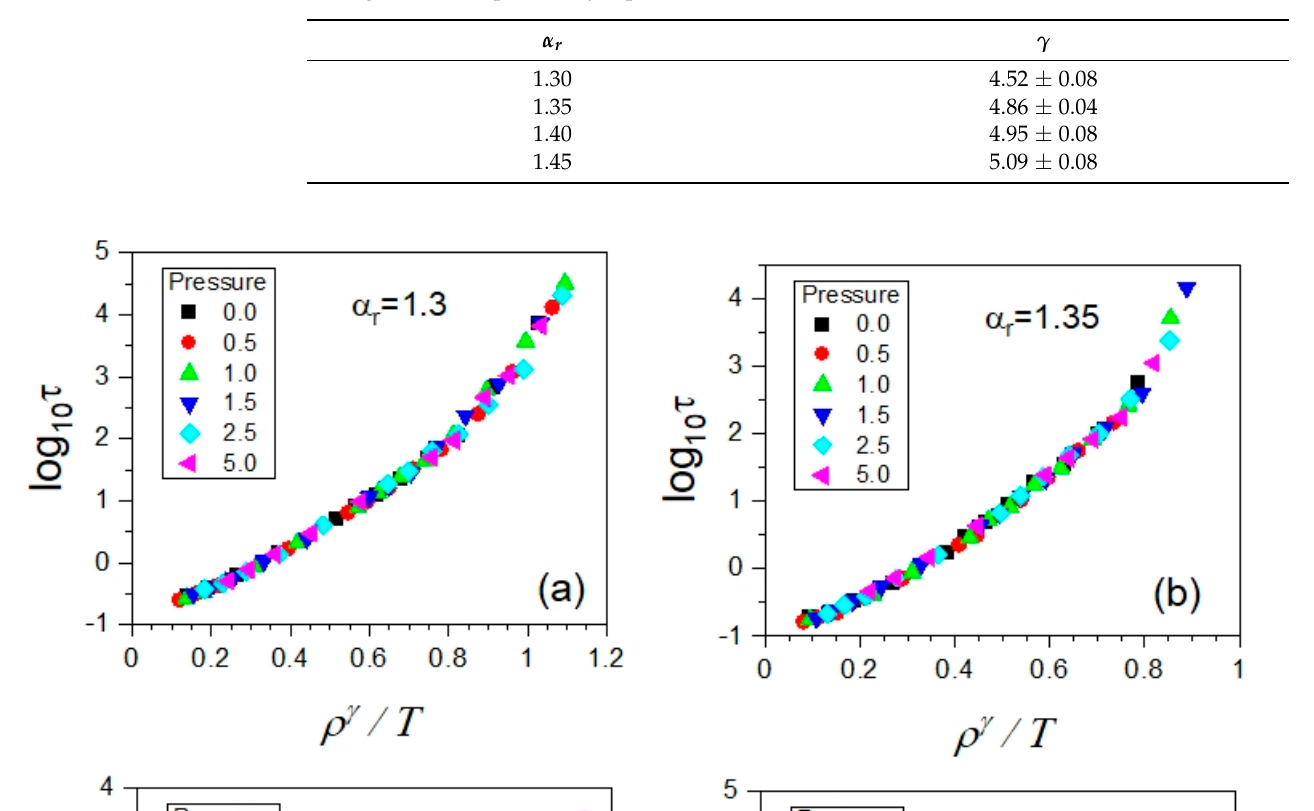
Table 2. The values of the density scaling exponent γ evaluated according to the density scaling criterion for all examined anisotropy aspect ratios α r as the slope coefficient of the linear isochronal correlations presented in Figure 5. The determination errors of the slope coefficient values are estimated as the standard deviation errors found from the linear regression of all the linear isochronal correlations shown in Figure 5 for a given anisotropy aspect ratio in accordance with the density scaling criterion expressed by Equation (2).